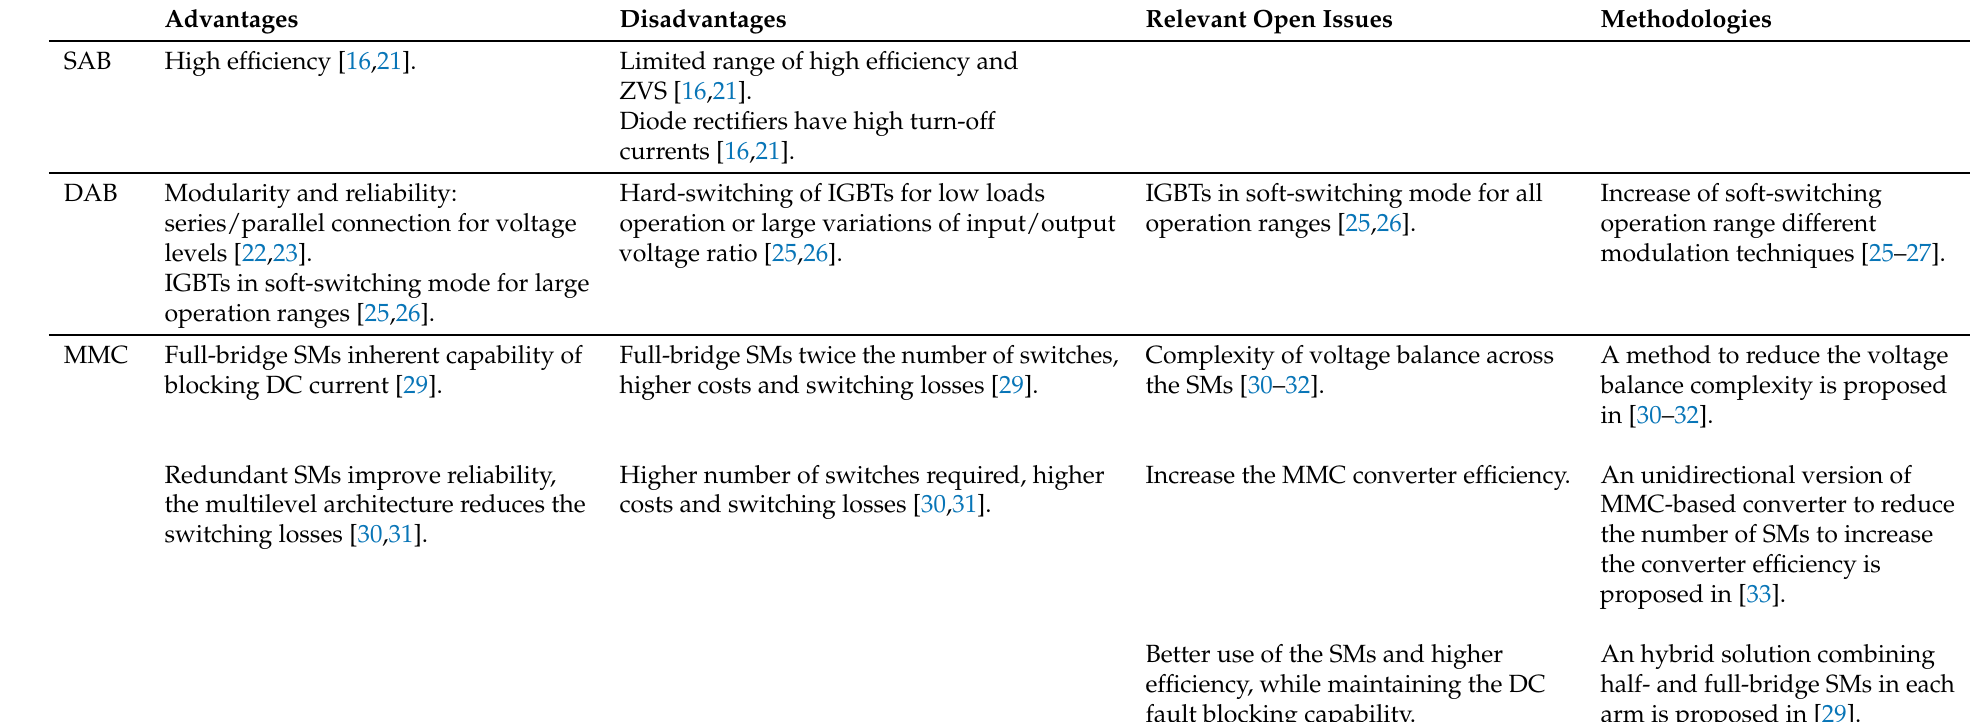
Table 1. Summary of DC/DC converter topologies presented in challenge